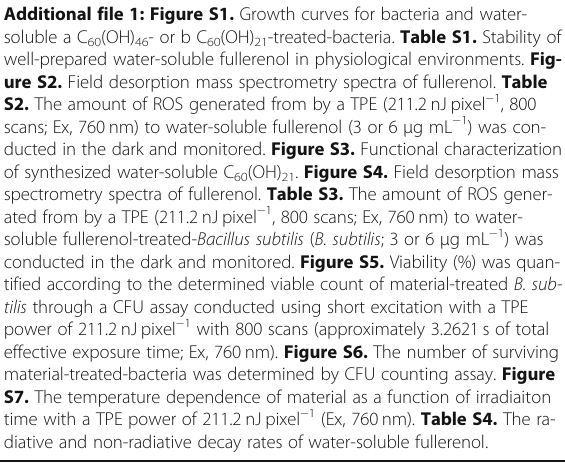
Additional file 1: Figure S1. Growth curves for bacteria and water- soluble a C 60 (OH) 46 - or b C 60 (OH) 21 -treated-bacteria. Table S1. Stability of well-prepared water-soluble fullerenol in physiological environments. Fig- ure S2. Field desorption mass spectrometry spectra of fullerenol. Table S2. The amount of ROS generated from by a TPE (211.2nJpixel − 1 , 800 scans; Ex, 760 nm) to water-soluble fullerenol (3 or 6 μ g mL − 1 ) was con- ducted in the dark and monitored. Figure S3. Functional characterization of synthesized water-soluble C 60 (OH) 21 . Figure S4. Field desorption mass